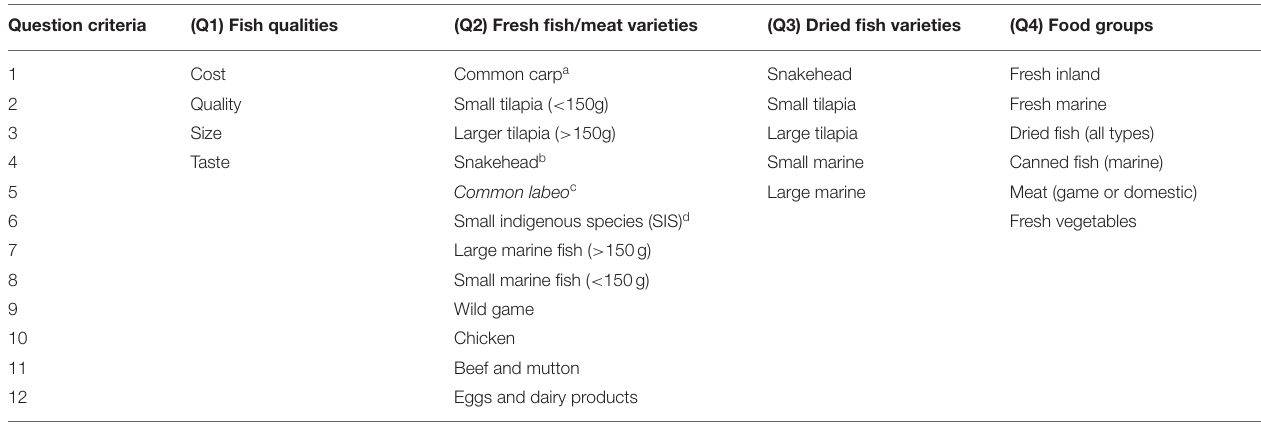
TABLE 5 | Inventory of food preference criteria elicited for phase 1 and 2 scoring and ranking exercises. Question